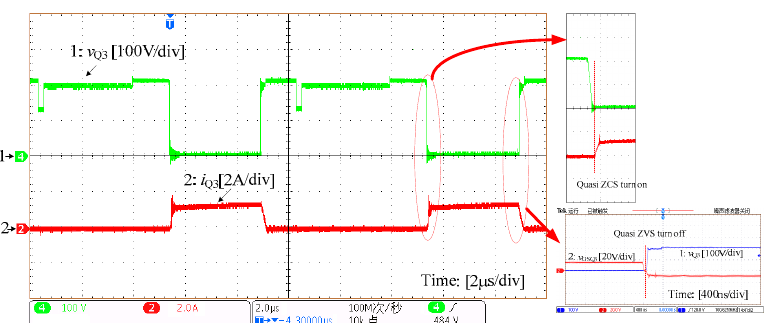
Figure 10. Waveform of v Q2P and i Q2P .